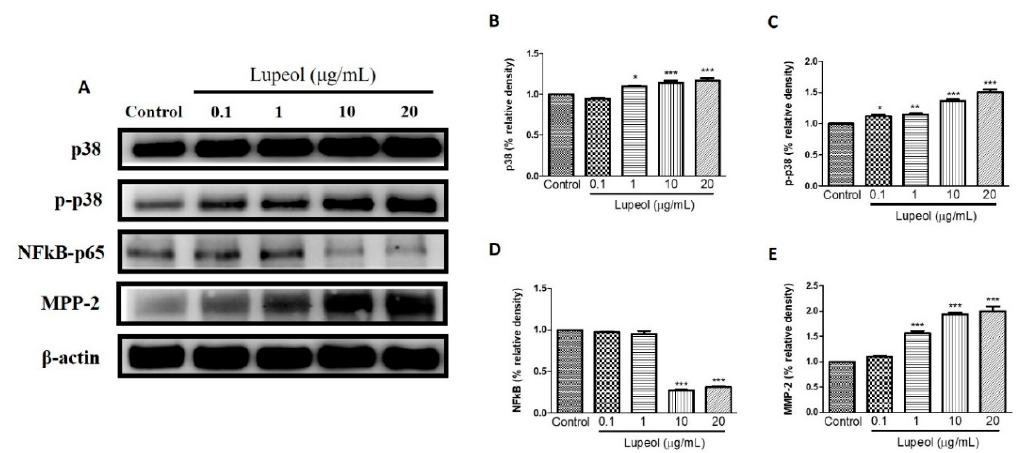
Figure 7. Lupeol regulates the expression of p-38, NF- κ B-p65 and MMP-2 in epidermal keratinocytes. ( A ) Western blot showing expression of p38, p-p38, NF- κ B-p65, and MMP-2 in keratinocytes after 24 h treatment with lupeol in different concentrations. ( B – E ) All the proteins were semi-quantitated using Image J software and normalized to the levels of β -actin. Data are expressed as mean ± SEM. * p < 0.05, ** p < 0.01, and *** p < 0.001 versus control group.